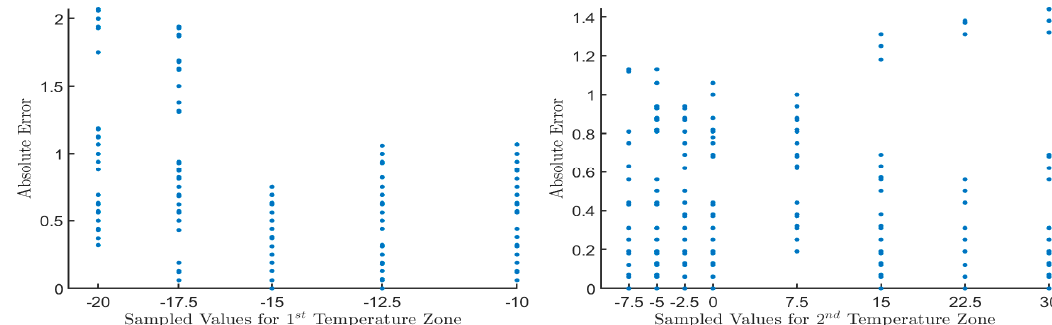
Figure 3. The AE regarding sampled values for both temperature areas. The AE for each sampled value is depicted with blue dots. The x ‐ axis shows the temperatures, while on the y ‐ axis, the AE calculated using Formula (7). The left diagram shows the 1st temperature zone’s measurement results where the AE ranged from 0 °C to 2.07 °C. The right graph shows the 2nd temperature zone’s measurement results, where the AE went from 0 °C to 2.07 °C.